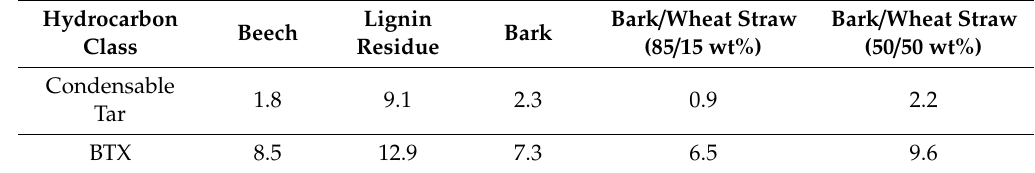
Table 4. Condensable tar and BTX concentrations in dry gas (in g / Nm 3